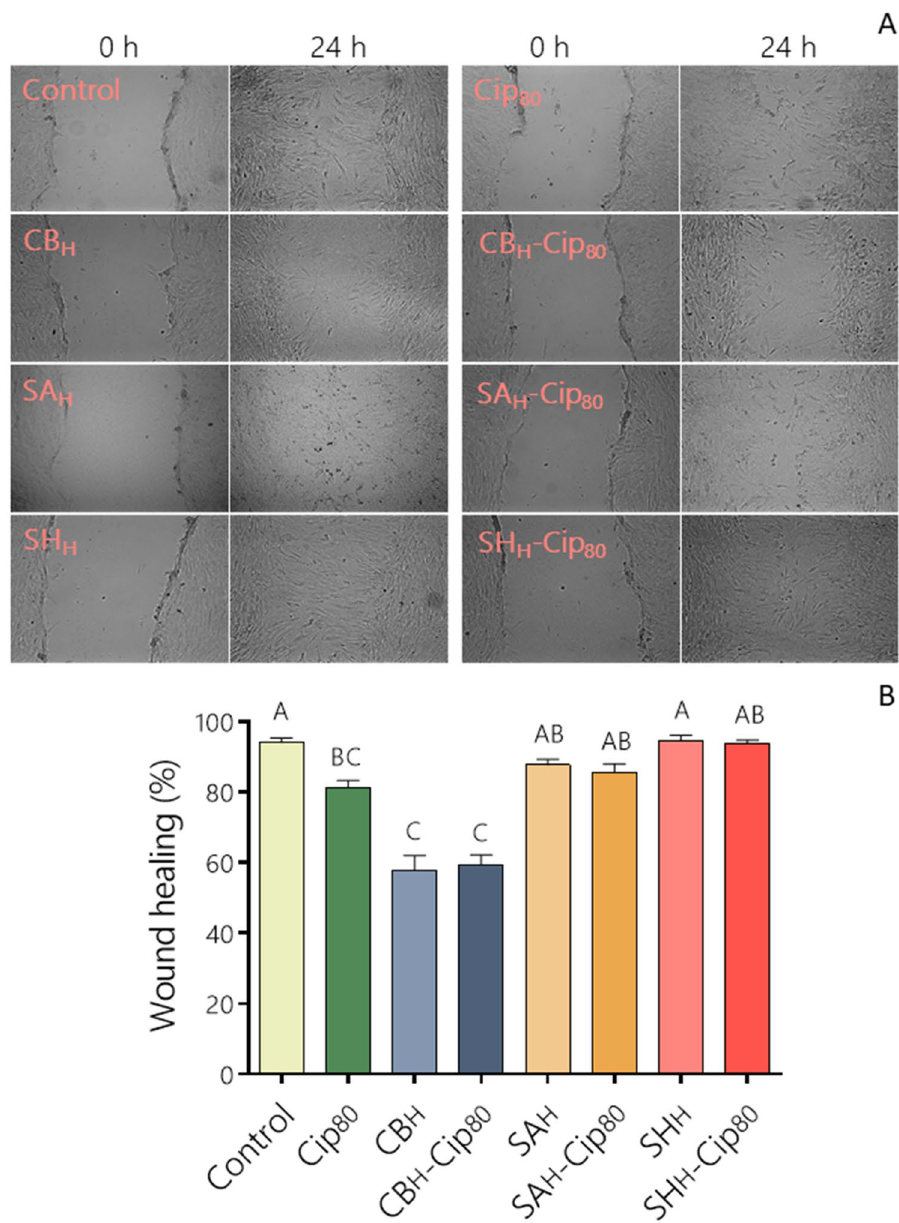
Figure 3. Effect of CB, SA, SH, or PE-Cip complexes on cell migration. ( A ) Representative images of wound healing assays performed on HDF cells treated as indicated. An open furrow was generated by scratching confluent cells using a pipette tip, and cells images were obtained at the initial time and after 24 h. ( B ) The distance between furrow edges in control or treated cells of three independent experiments was measured and presented graphically as the percentage of the initial distance (0 h) according Eq. (2); p < 0.05 compared to control cells. Different capital letters above the bars indicating significant differences. Plotted with GraphPad Prism v.7.00 software (GraphPad, USA, https:// www. graph pad.